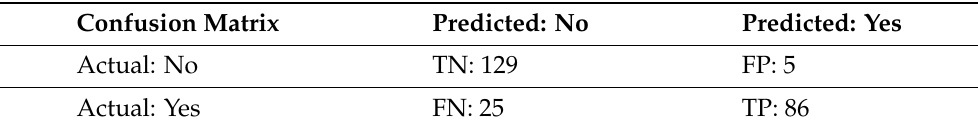
Table 20. Confusion Matrix: